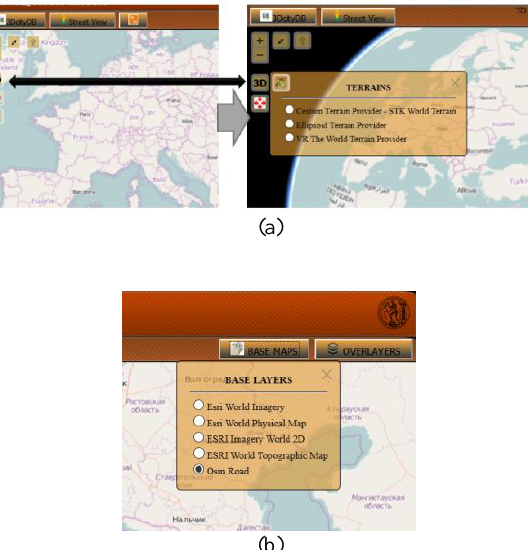
Figure 7. Terrain (a) and base maps (b) selection